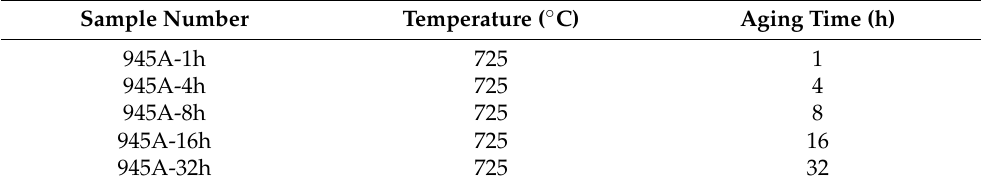
Table 2. The parameters of the aging treatment on the 945A Ni-based superalloy.